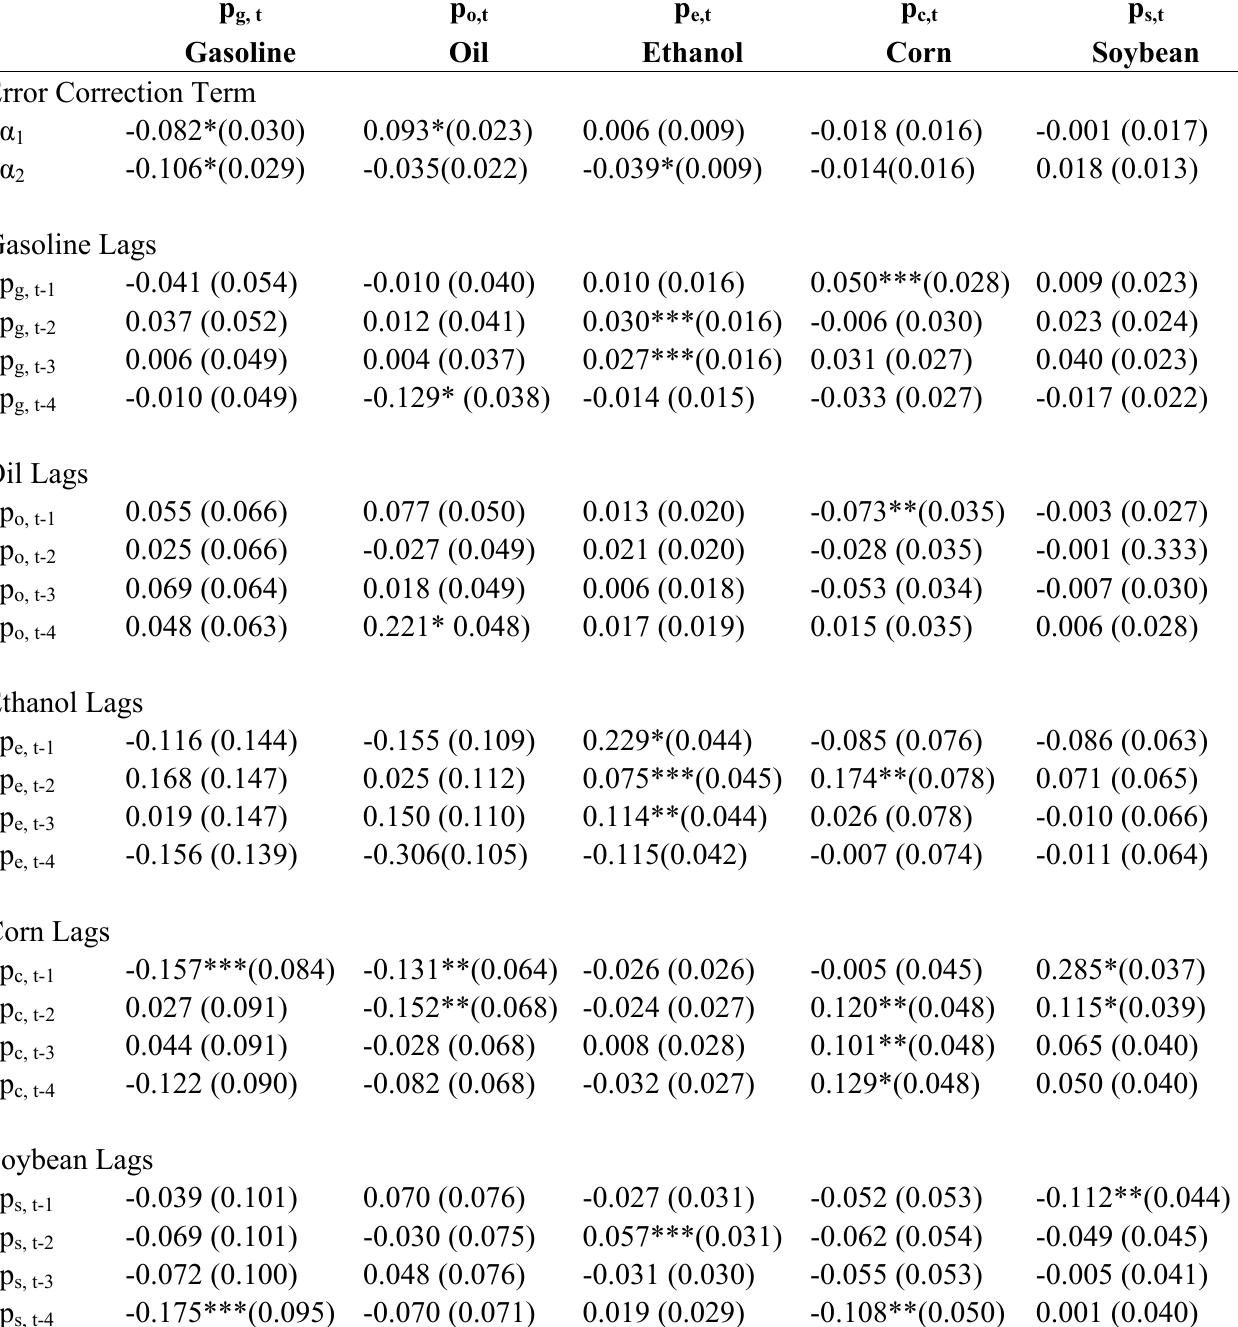
Table A1. Pre-Ethanol Boom, 1989-1999 VECM